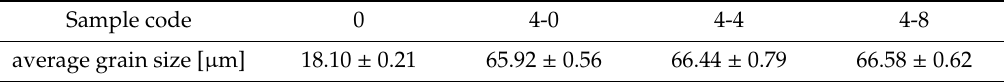
Figure 7. Influence of Si 3 N 4 addition on the a ) amount of borides and b ) percentage of grain surface occupied by borides. Data are for selected representative samples with 0.4 wt% boron addition.